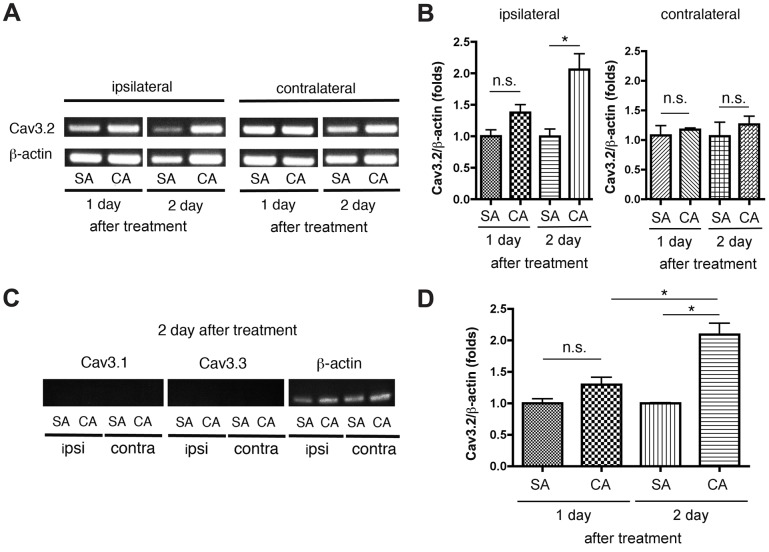
Cav3.2 mRNA is gradually upregulated in ipsilateral L5 DRG tissues during the sub-acute phase (Days 1–2) following carrageenan injection.(A and B) Representative gel images of semi-quantitative RT-PCR analyses showing an upregulation of Cav3.2 mRNA (A) and data (proportion relative to ß-actin) quantified by densitometry (B). (C) Representative images of semi-quantitative RT-PCR analyses of Cav3.1 and Cav3.3 mRNA on Day 2 showing no upregulation (n = 3 mice for Day 1 and n = 4 mice for Day 2). (D) Summary of data from the quantitative RT-PCR (qRT-PCR) analyses. The results were similar to the results of the semi-quantitative RT-PCR: Cav3.2 mRNA was increasingly upregulated during the sub-acute phase of hyperalgesia (n = 4 mice for each group). *p < 0.05 compared with saline-treated controls (one-way ANOVA with the Bonferroni post hoc test). n.s., not significant; SA, saline; CA, carrageenan; ipsi, ipsilateral; contra, contralateral.